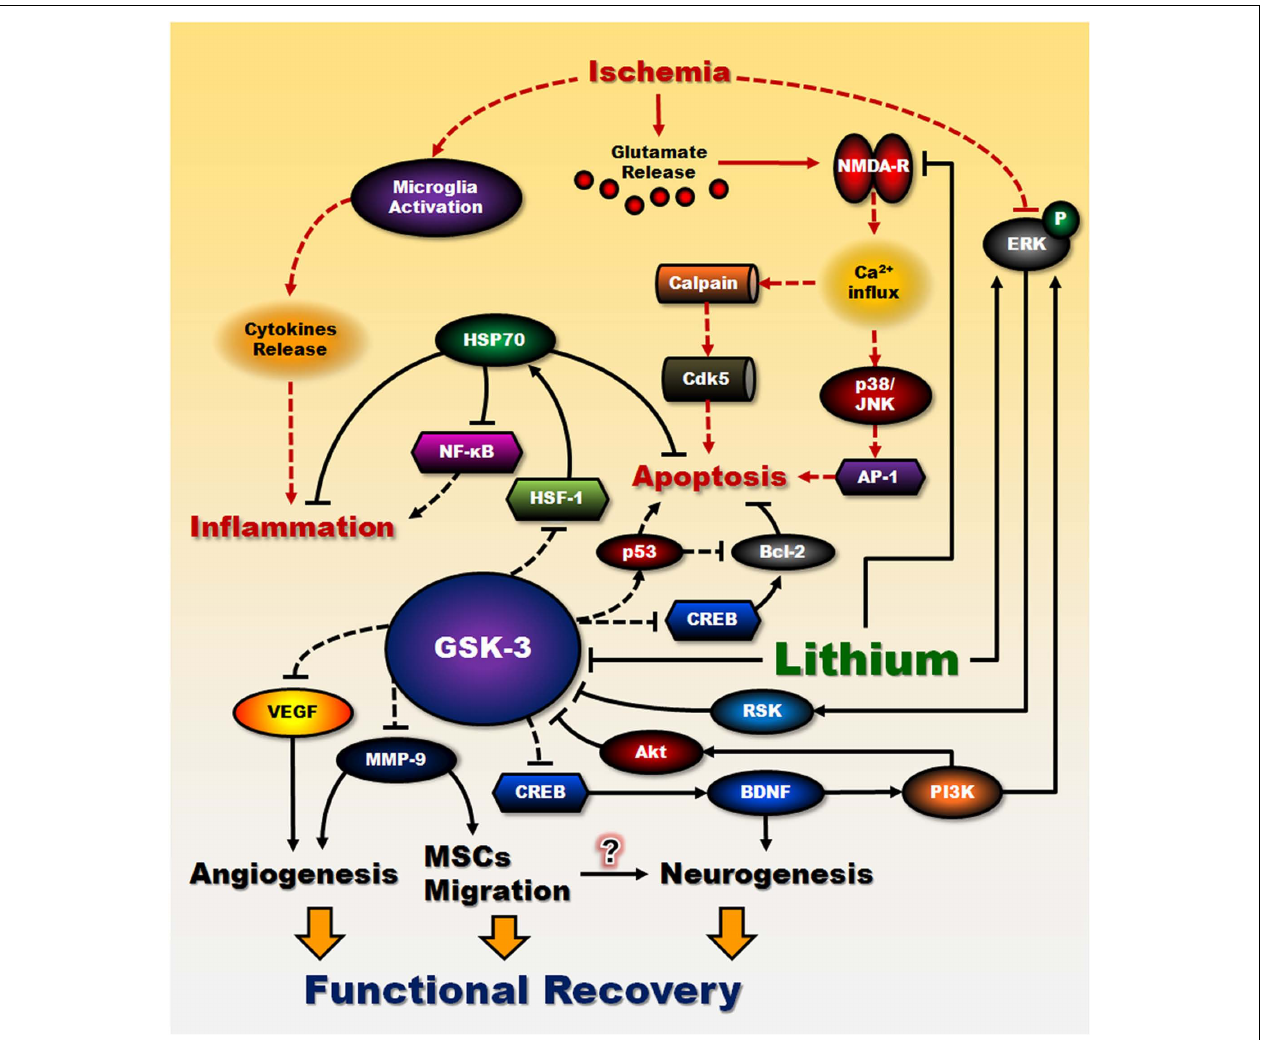
FIGURE 3 | Proposed lithium’s neuroprotective effects against cerebral ischemia. The neuroprotective effects of lithium against cerebral ischemia are proposed to result from its interactions with cell survival and apoptotic machinery. A significant portion of brain damage following cerebral ischemia is caused by an increase in extracellular glutamate and subsequent over-stimulation of NMDA receptor-mediated toxic increase in intracellular calcium.This signaling pathway plays a critical role in mediating glutamate-induced caspase activation and apoptosis. Lithium at therapeutically relevant concentrations inhibits NMDA receptor-mediated calcium influx, which in turn decreases subsequent activation of JNK, p38 kinase, and transcription factor AP-1. Inhibition of intracellular calcium increase also attenuates the activity of calpain and calpain-mediated activation of pro-apoptotic Cdk5/p25 kinase. On the other hand, lithium can directly and indirectly reduce the activity of constitutively activated GSK-3 by multiple mechanisms, leading to disinhibition of several transcription factors, such as CREB and HSF-1, and resulting in induction of major cytoprotective proteins such as BDNF,VEGF, MMP-9, HSP70, and Bcl-2. A decrease in GSK-3 activity further reduces the activity of pro-apoptotic protein p53 and its